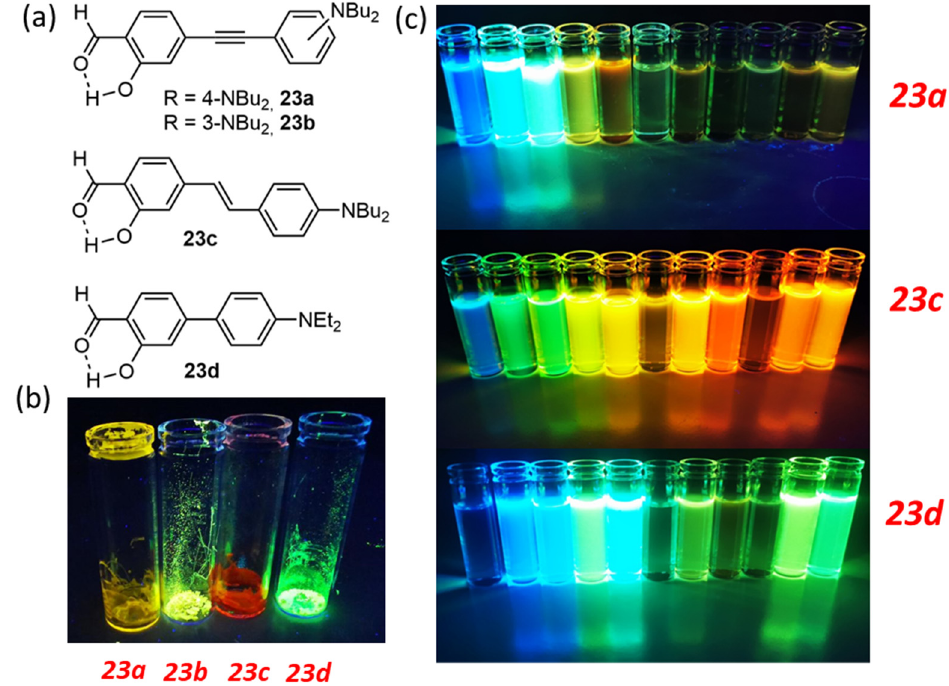
Figure 7. ( a ) DSE/ESIPT fluorophores based on a salicylaldehyde scaffold and photographs of dyes 23a–d under irradiation ( λ exc = 365 nm) in ( b ) solution (from left to right: cyclohexane, toluene, diethylether, THF, dichloromethane, protonated dichloromethane, acetone, acetonitrile, ethanol, DMSO and DMF) and ( c ) in the solid-state as powders [82]. Adapted from ref [82] Copyright 2021 John Wiley and Sons.